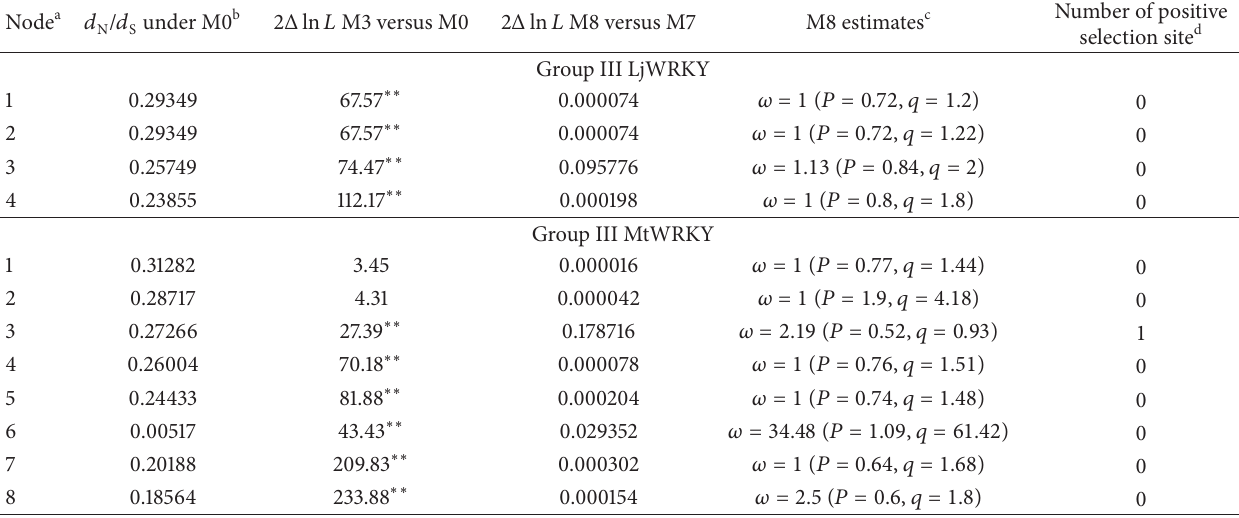
Node number from the phylogenetic tree. b 𝑑